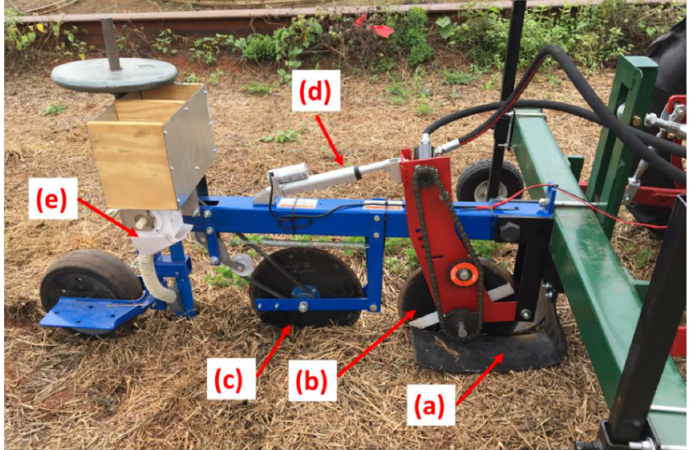
Figure 2. Modified Morrison no-till drill with powered coulter for effective cover crop cutting. ( a ) rubber shield to press cover crop against the soil; ( b ) powered coulter with hydraulic motor drive to cut the cover crop residue and topsoil [14]; ( c ) secondary coulter with welded spikes (on opposite side: not shown) for better engagement with the soil and to power the metering unit of the drill; ( d ) electric linear actuator to control the depth of the powered coulter in the soil; ( e ) metering unit assembly with seed discharge tube, seed dispensing box, and rubber closing